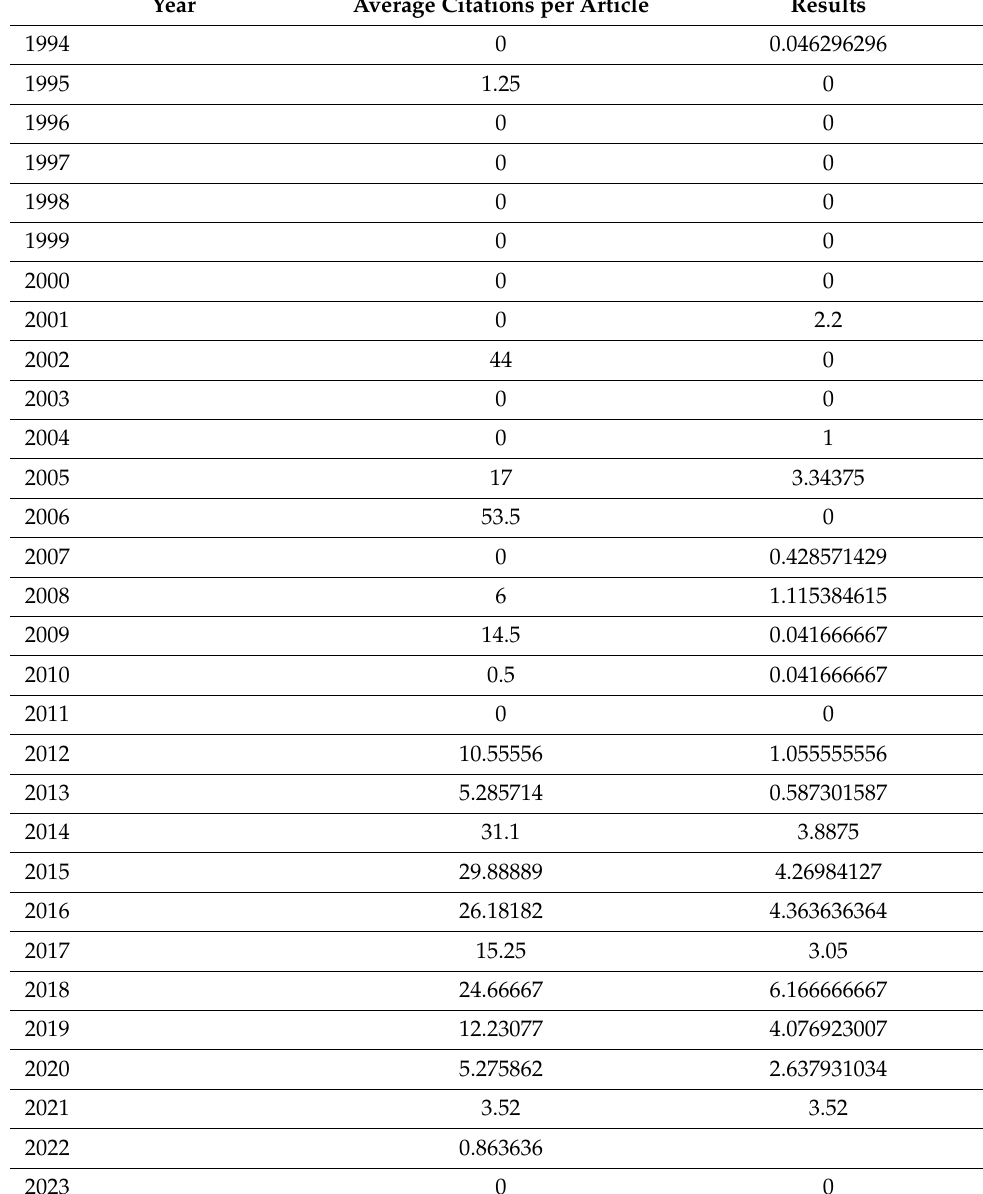
Table 2. Annual production